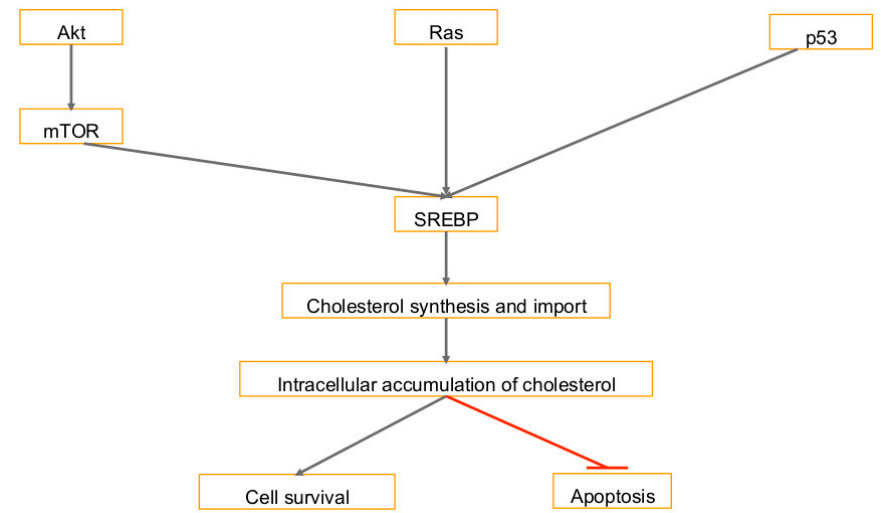
Figure 2. Pathways that lead to an accumulation of cholesterol: Activation of SREBP transcription factor induces cholesterol. This is induced by activation of PI3K/Akt/mTOR signaling, cancer gene RAS, and dysregulation by TP53. The accumulation of cholesterol in the cell promotes survival and inhibits apoptosis. T-bar in red denotes inhibition.